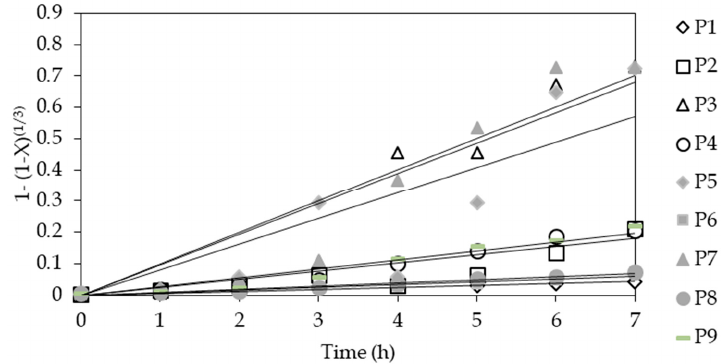
Figure 13. Linear regression of the chemical reaction model.